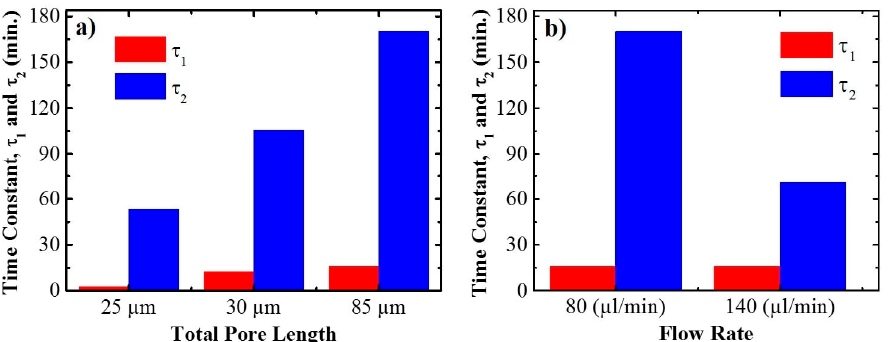
Figure 9. Trend obtained of the two different characteristic time releases of drug from the whole structure as a function of total pore length ( a ), and flow rate ( b ), respectively.